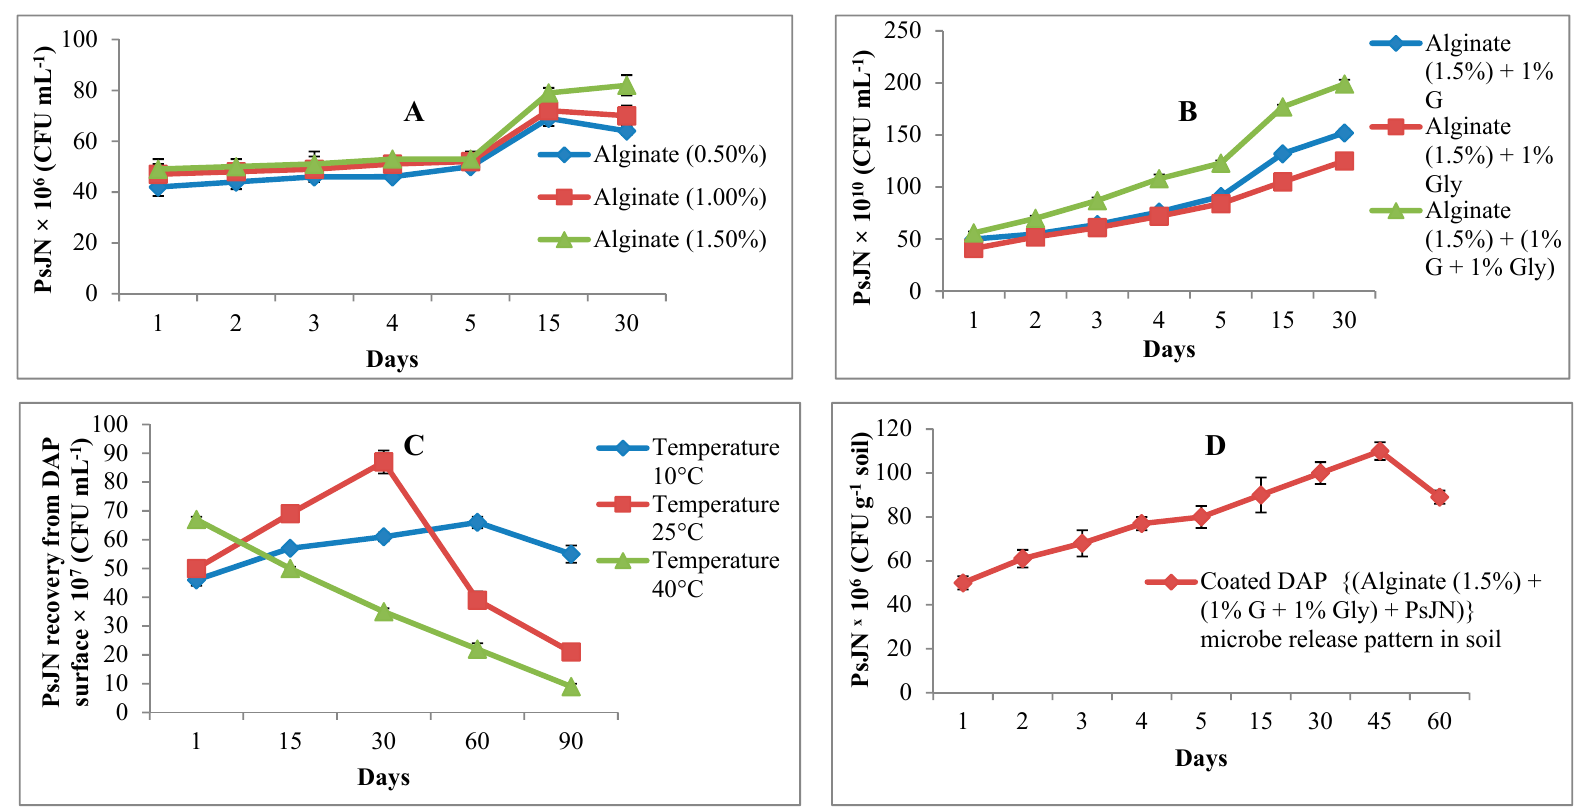
Figure 1. Viability of endophytic bacterium Burkholderia phytofirmans PsJN in ( A ) different concentrations of polymer prototype solution, ( B ) selected concentration of polymer prototype solution amended with carbon sources, ( C ) recovery of PsJN from coated DAP surface stored at different temperatures, and ( D ) release pattern of PsJN from coated DAP in soil. Note: G—glucose; Gly—Glycerol; CFU—colony forming unit, n = 3.